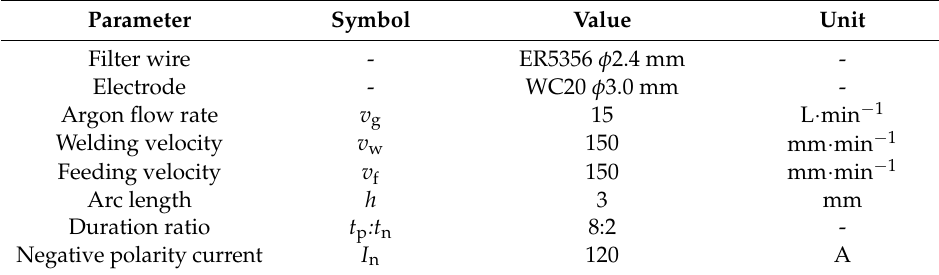
Table 2. Constant welding process